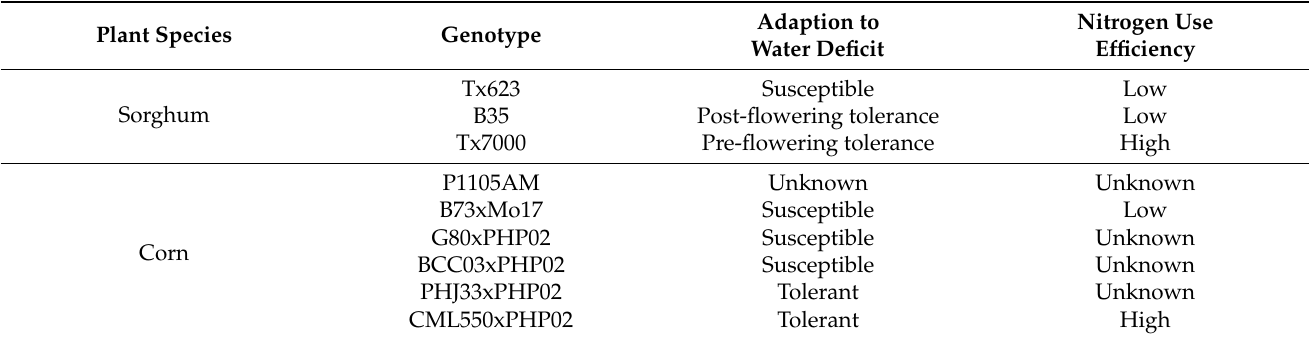
Table 1. Adaptation to water deficit and nitrogen use efficiency of the genotypes investigated in the